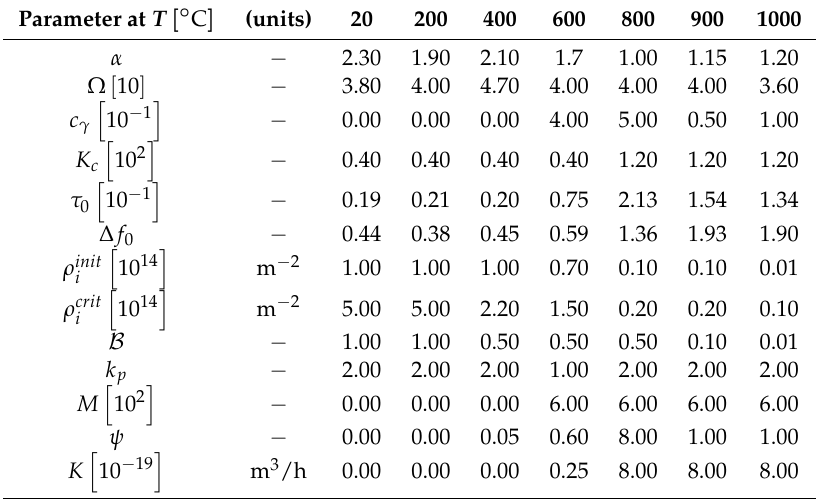
Temperature-dependant parameters of the dislocation density model (Taken from Babu